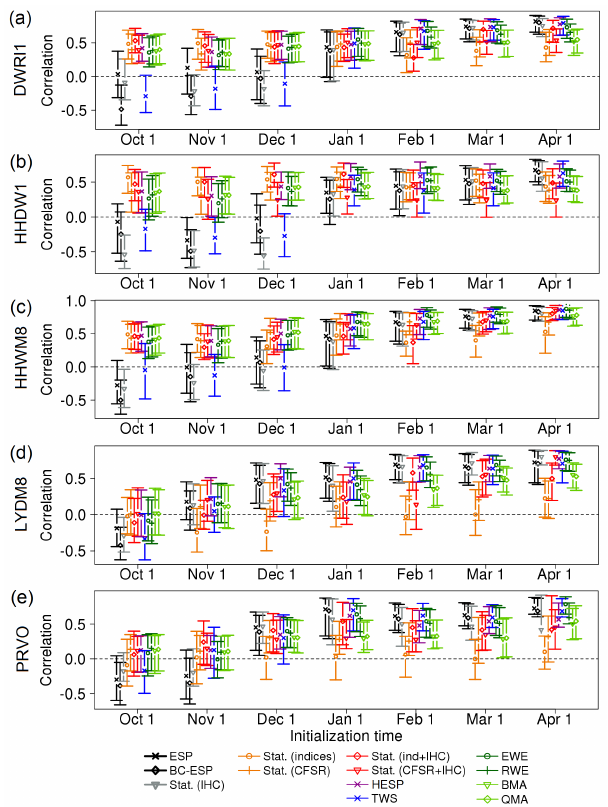
Figure 5. Correlation coefficients of forecast ensemble medians versus observations obtained from all methods at different initial- ization dates. The error bars define 95% confidence limits ob- tained through bootstrapping with replacement. Results are dis- played for (a) Dworshak Reservoir inflow (DWRI1), (b) Howard Hanson reservoir inflow (HHDW1), (c) Hungry Horse reservoir in- flow (HHWM8), (d) Libby dam inflow (LYDM8), and (e) Prineville reservoir inflows